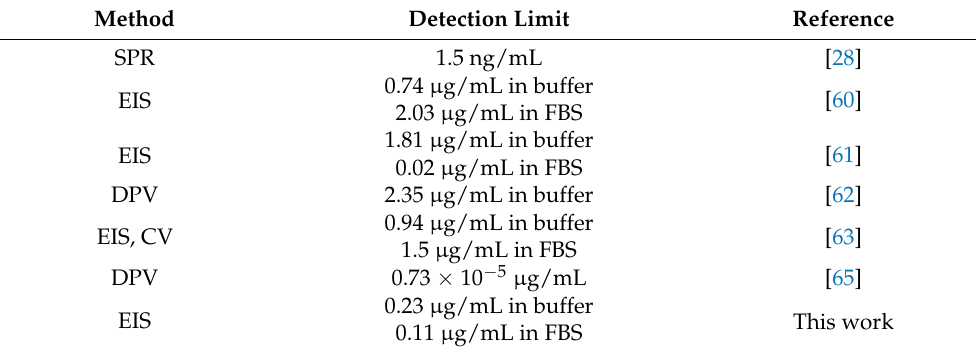
Table 2. Overview of some of the previous methods developed using DNA aptamers for detecting activated protein